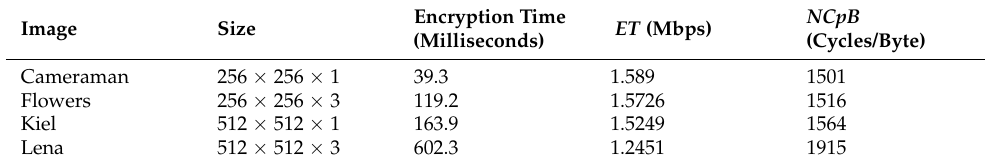
Table 12. The proposed encryption system’s computing performance. Image Size